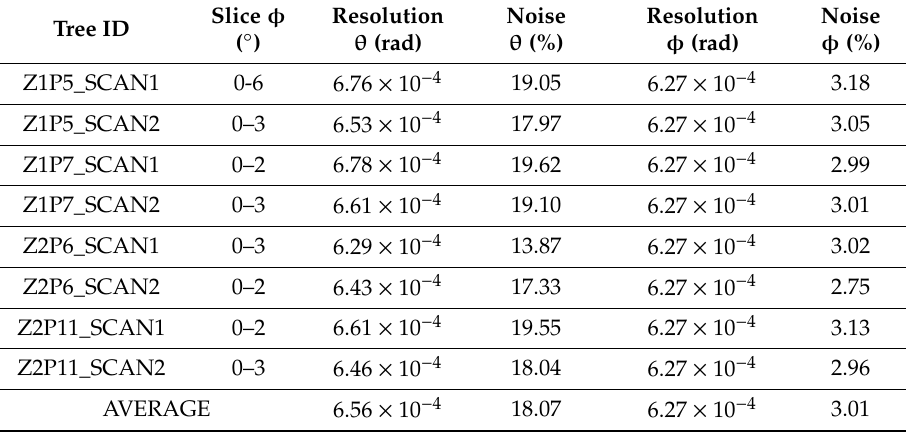
Table 5. Noisy φ slices for each Tree ID, computed angular resolution and noise. Tree